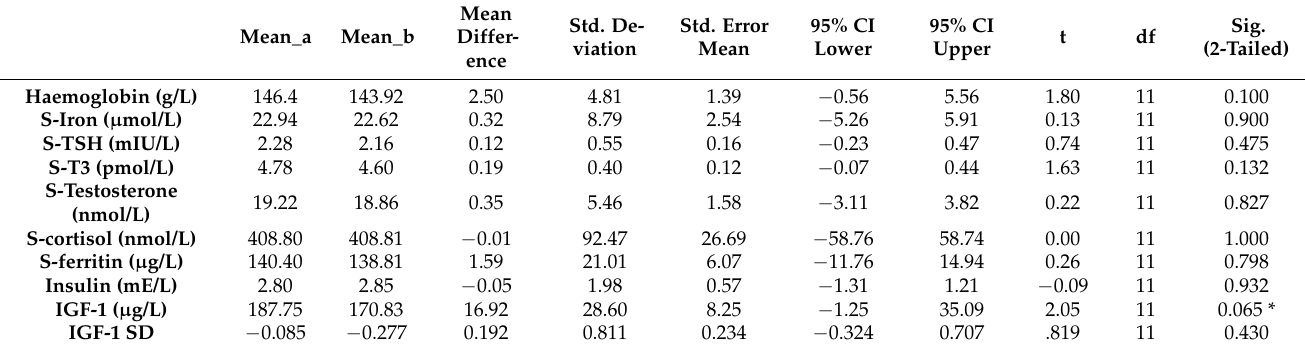
Table 1. t -test comparing blood parameters before (a) and after (b) 50% EA